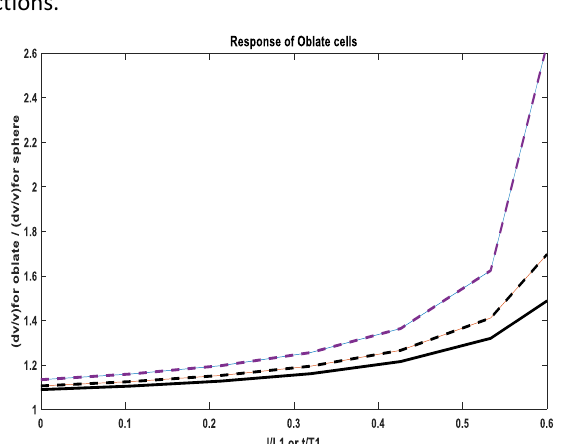
Fig.6: Response of oblate cells as compared to the spherical cells with the same